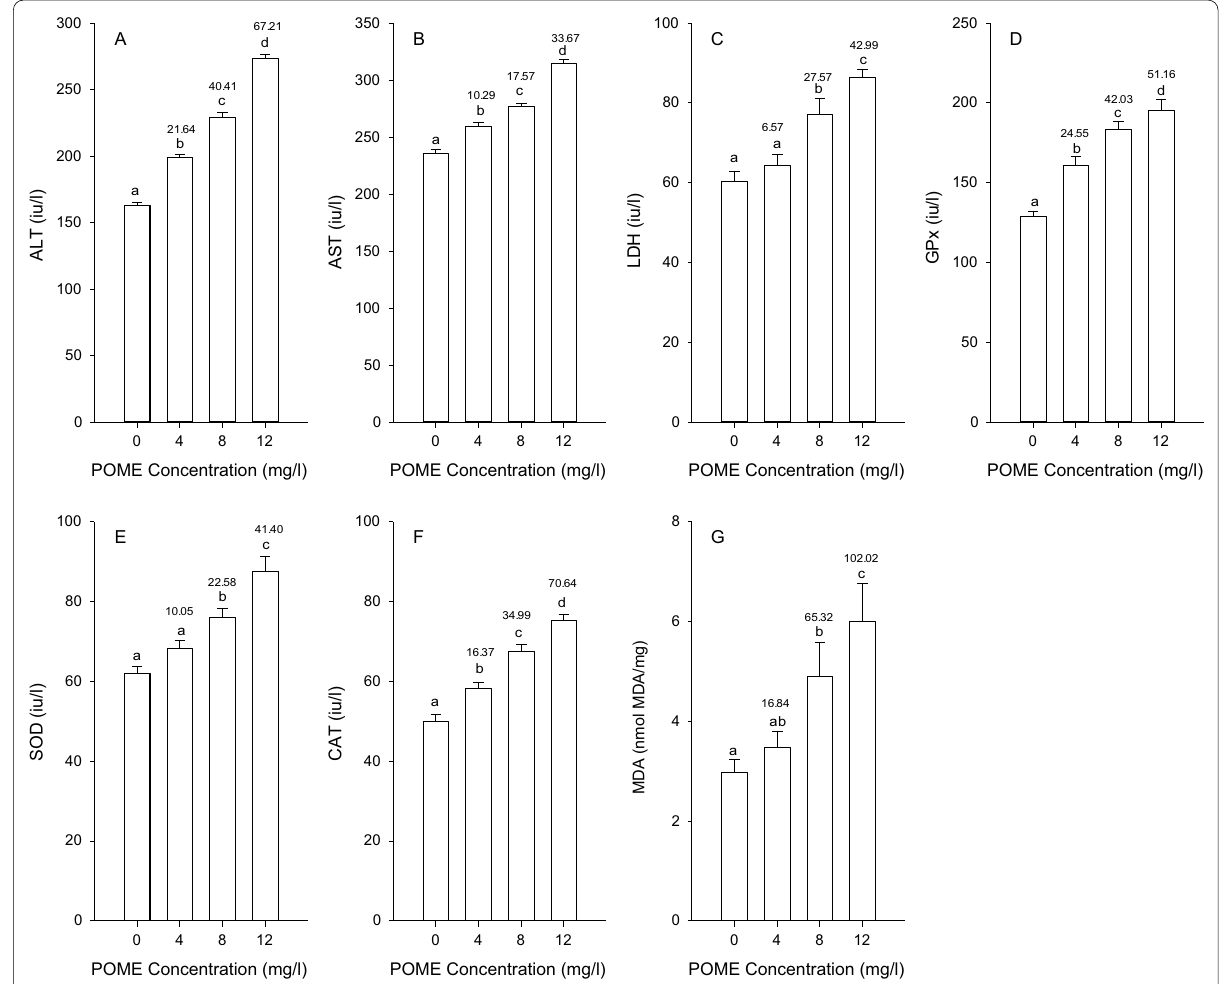
Fig. 2 Biochemical changes in the gill of Heteroclarias exposed to different concentrations of POME for 28 days. a ALT (alanine transaminase), b AST (aspartate transaminase), c LDH (lactate dehydrogenase), d GPx (glutathione peroxidase), e SOD (superoxide dismutase), f CAT (catalase), g MDA